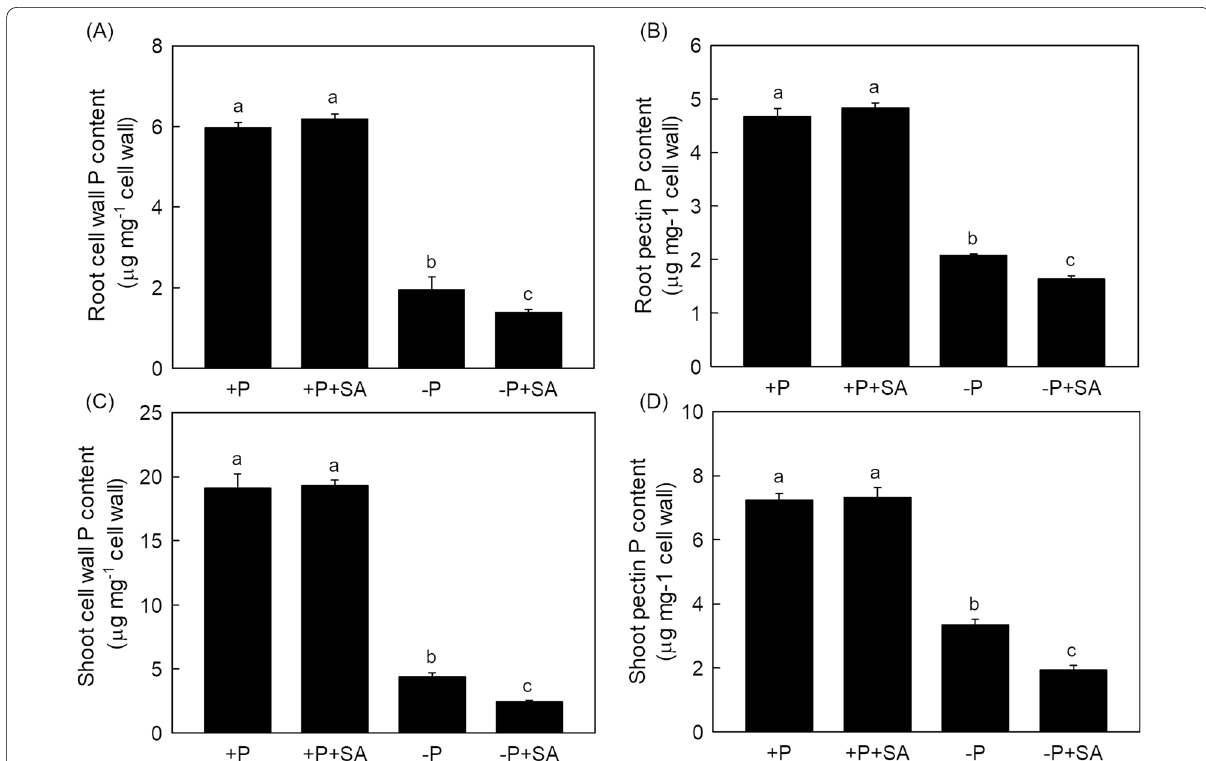
Fig. 4 SA affects the root and shoot cell wall reutilization in rice. Cell wall P content in root ( A ) and shoot ( C ), pectin P content in root ( B ) and shoot ( D ) were measured. Data are means SD ( n 4). Different letters represent significant differences by Duncan’s multiple range test at the P < ± =